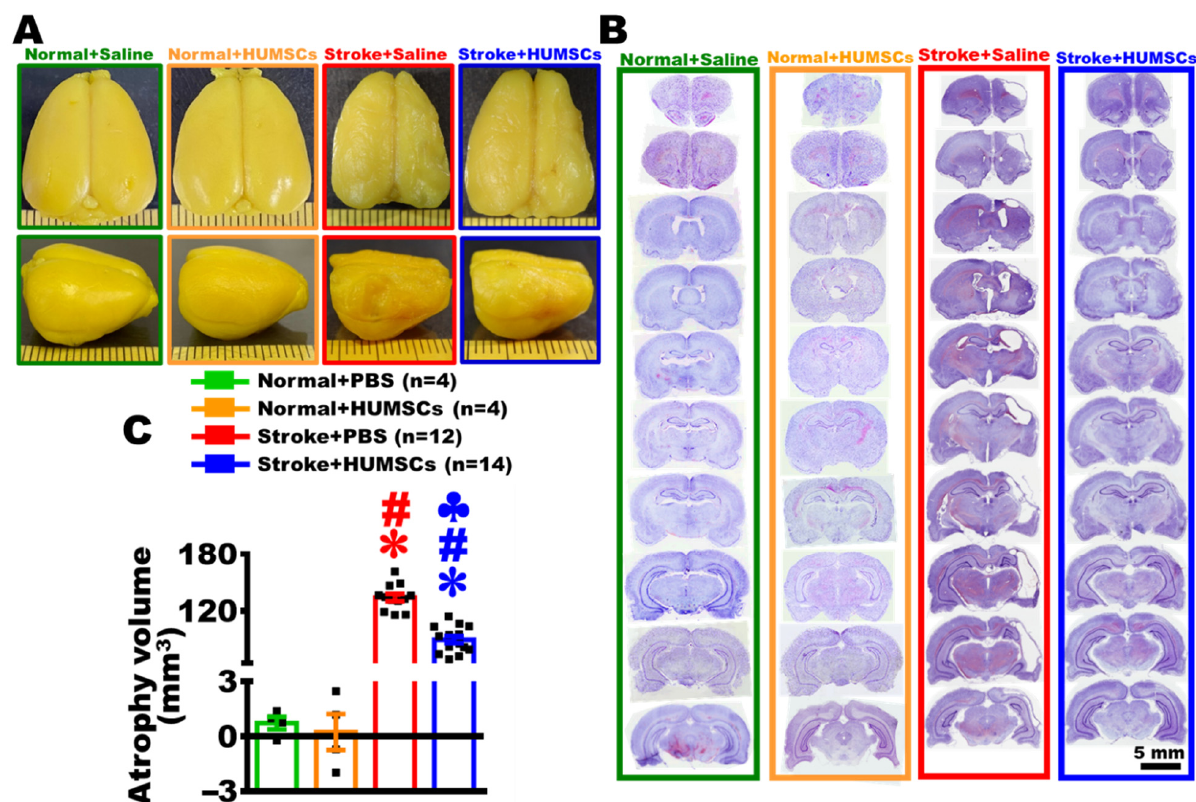
Figure 3. HUMSCs transplantation preserved the cerebral cortex in rats with chronic stroke. On day 56 post stroke, the brains fixed with paraformaldehyde were photographed from a superior (top panel) and a lateral view (bottom panel). The brain of the Stroke + Saline group exhibited more severe atrophy in the cortex than that grafted with HUMSCs ( A ). Subsequently, the brains of four groups were subjected to serial coronal sections (from bregma +2.52 mm to − 5.76 mm) and stained with cresyl violet to observe alterations in the cerebral cortex. The results showed that the brain grafted with HUMSCs had more preserved cortices ( B ). The volume of atrophy in the infarcted cortex was quantified using the sections stained by cresyl violet, the result indicated the atrophy volume of the Stroke + HUMSCs group was substantially lower than that of the Stroke + Saline group ( C ). Normal + Saline n = 4, Normal + HUMSCs n = 4, Stroke + Saline n = 12, Stroke + HUMSCs n = 14. ∗ , vs. the Normal + Saline group, p < 0.05. #, vs. the Normal + HUMSCs group, p < 0.05. ♣ , vs. the Stroke + Saline group, p < 0.05. ■ is the value of individual experiment.